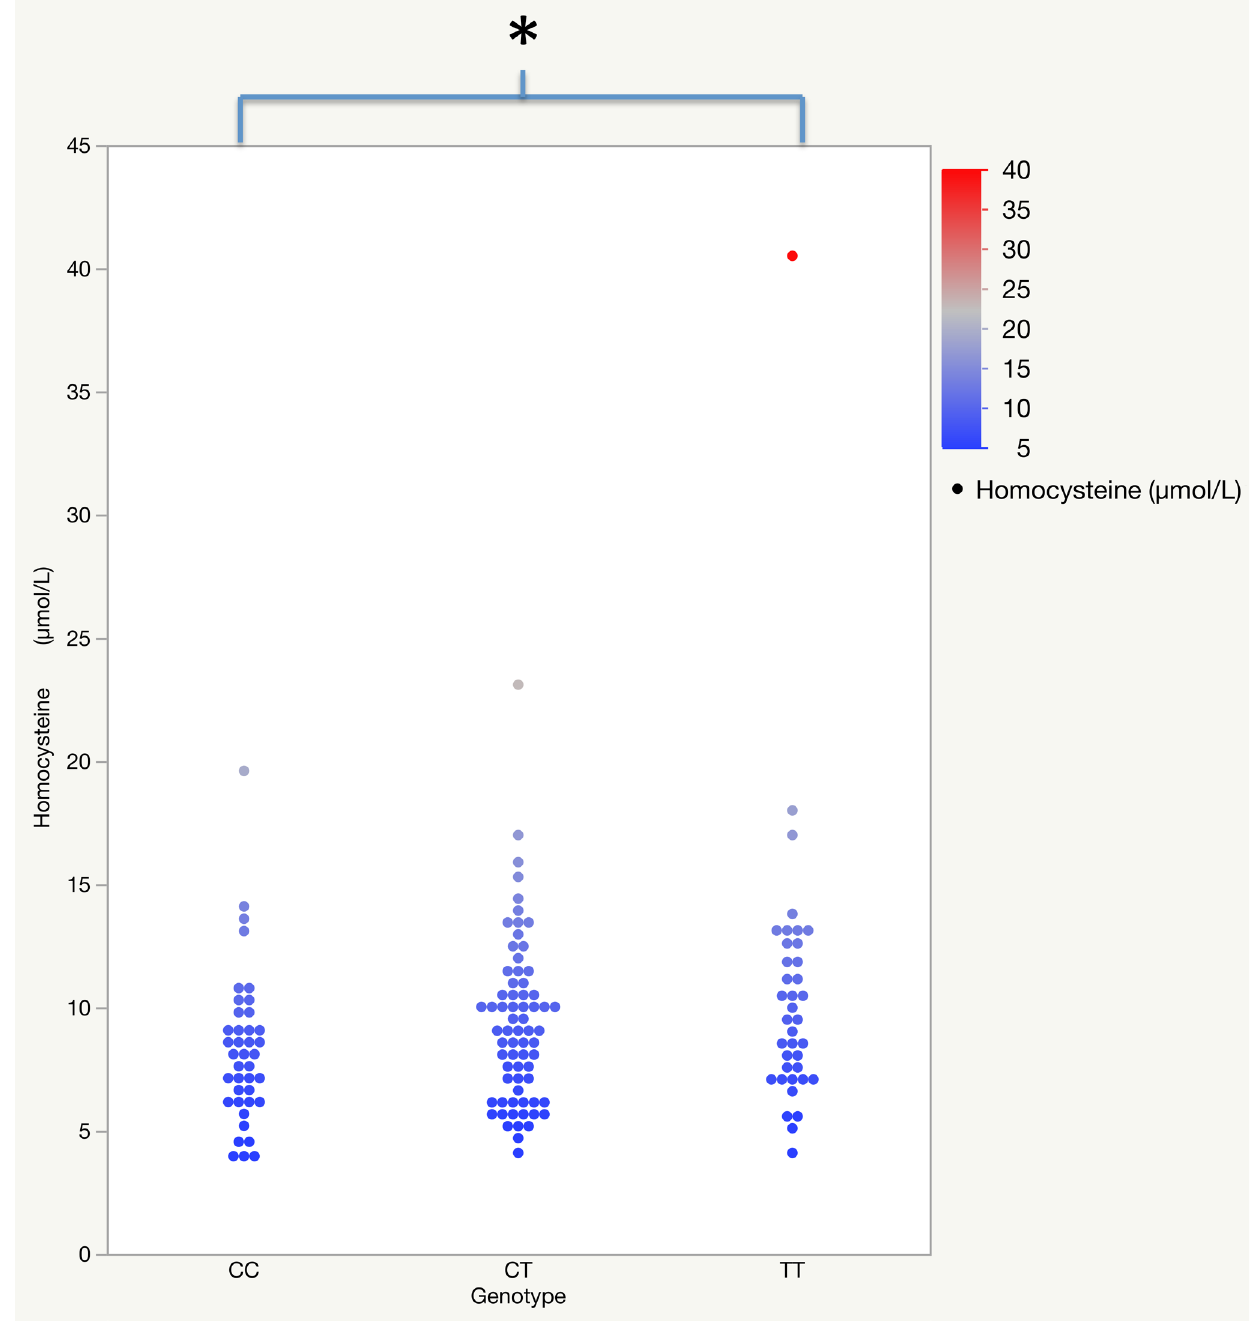
Figure 2. The variance of homocysteine level related to MTHFR genotype groups. One-way ANOVA analysis to compare Hcy concentrations among the three groups of MTHFR C677T genotype . The analysis includes outliers. *p-value =